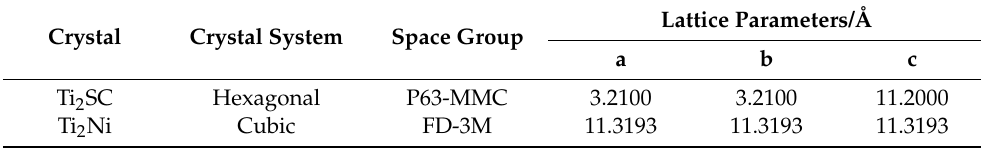
Table 7. The lattice parameters of Ti 2 SC and Ti 2